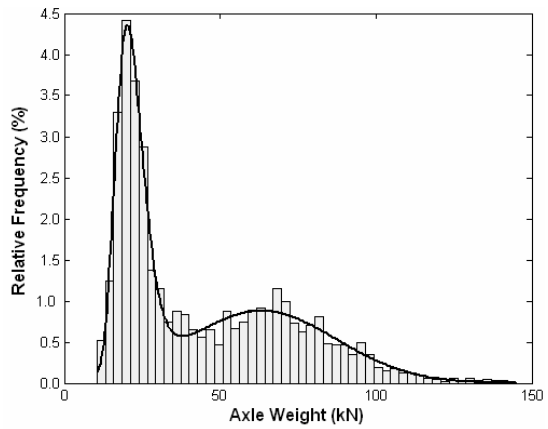
Fig 4. Typical axle weight distribution